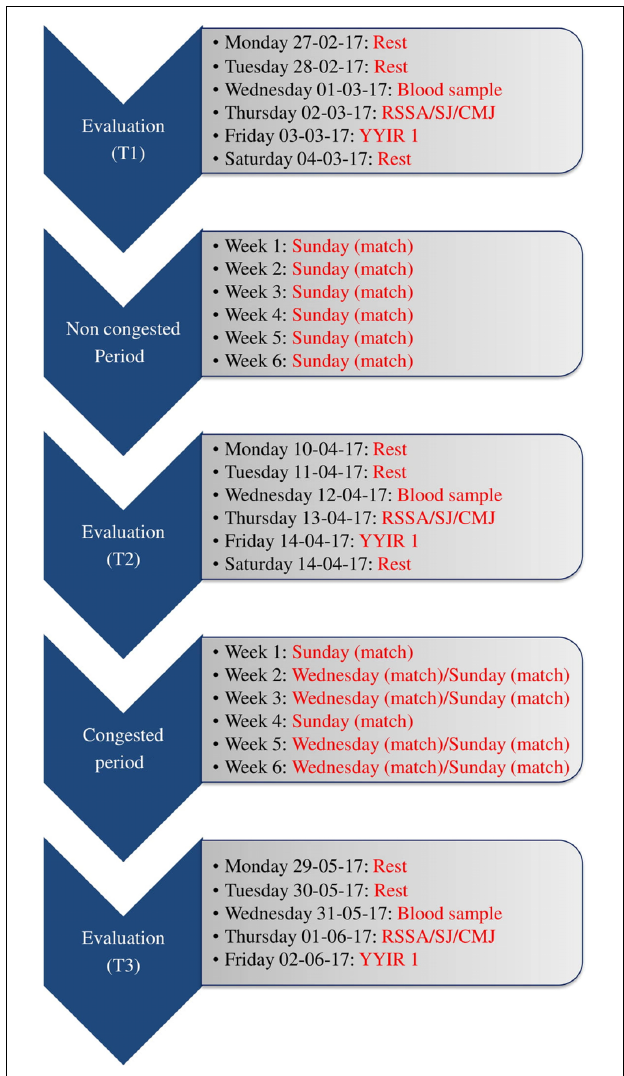
FIGURE 1 | Experimental procedures. RSSA: Repeated Sprint Shuttle Ability. YYIR 1: Yo-Yo intermittent recovery test level 1. SJ: Squat Jump. CMJ: Countermovement Jump